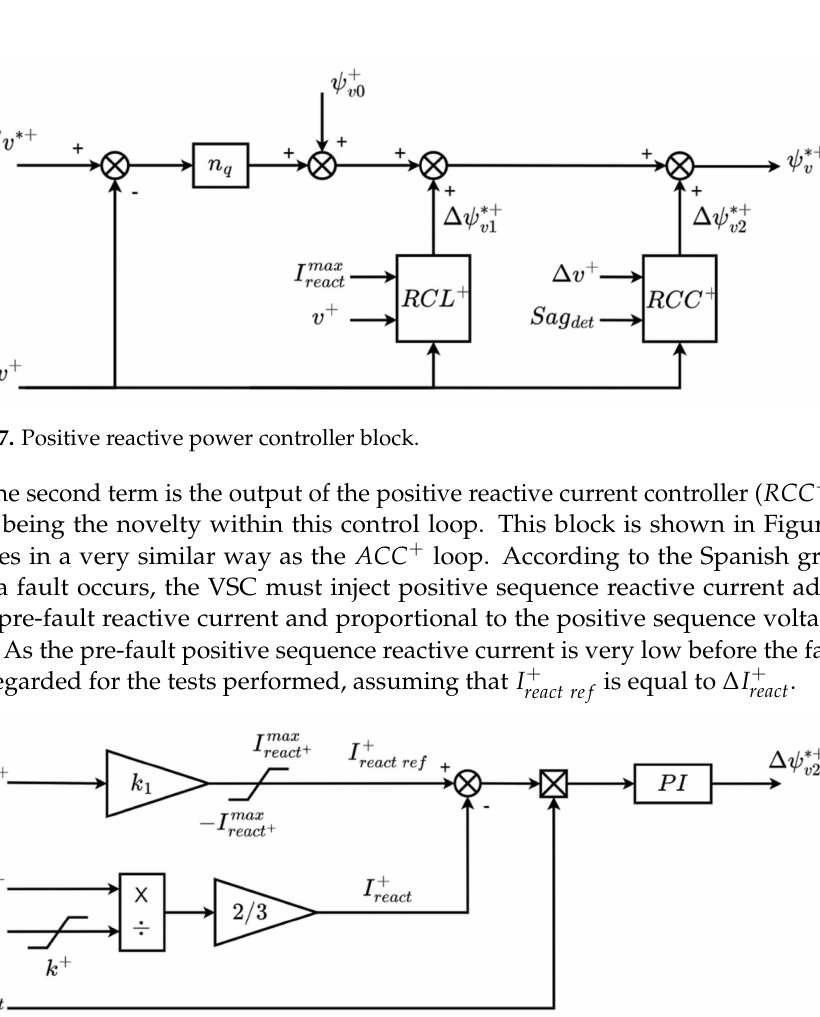
Figure 8. Positive reactive current controller